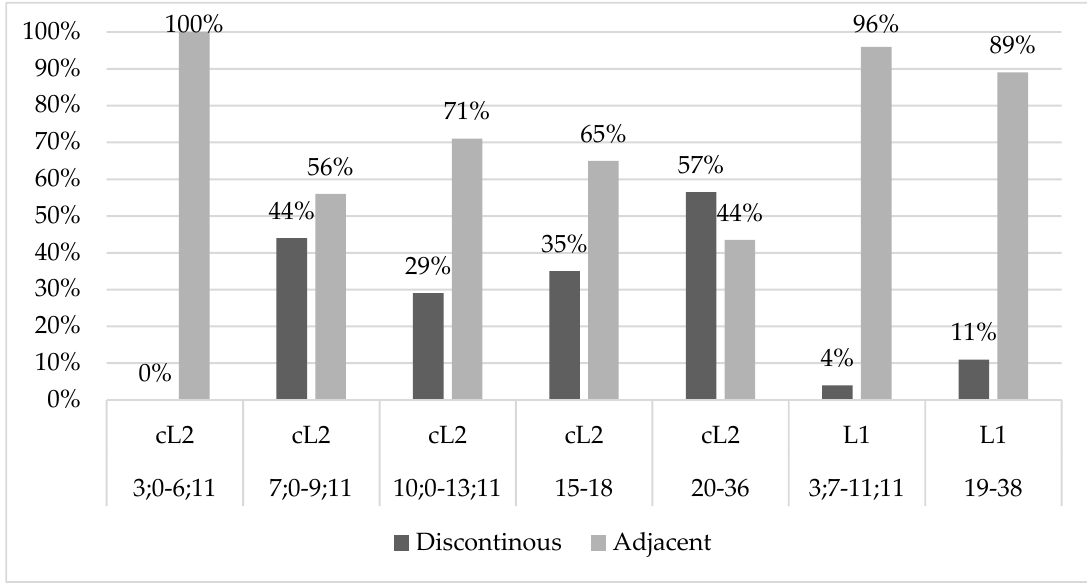
Figure 5. Relative frequency of discontinuous vs. adjacent word order pattern in verb phrases with noun phrases (NPs) in early sequential bilinguals (cL2) and monolinguals (L1).